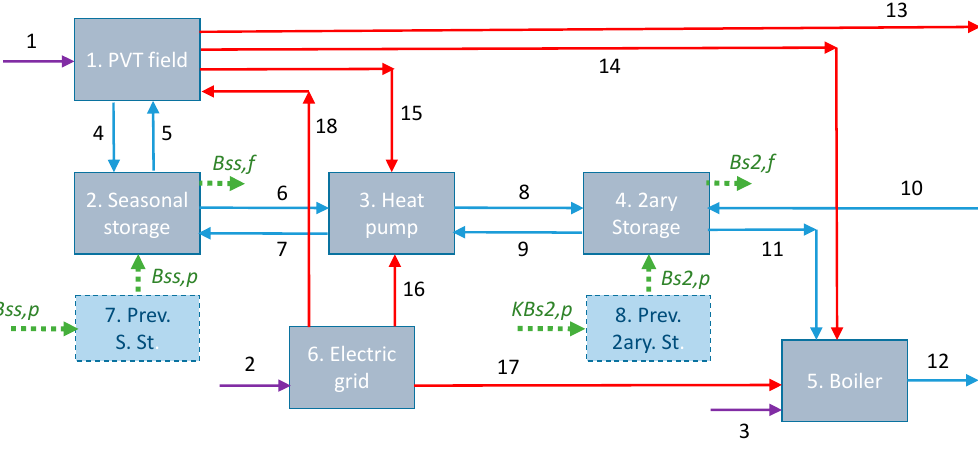
Figure 4. Flows and components of the system.